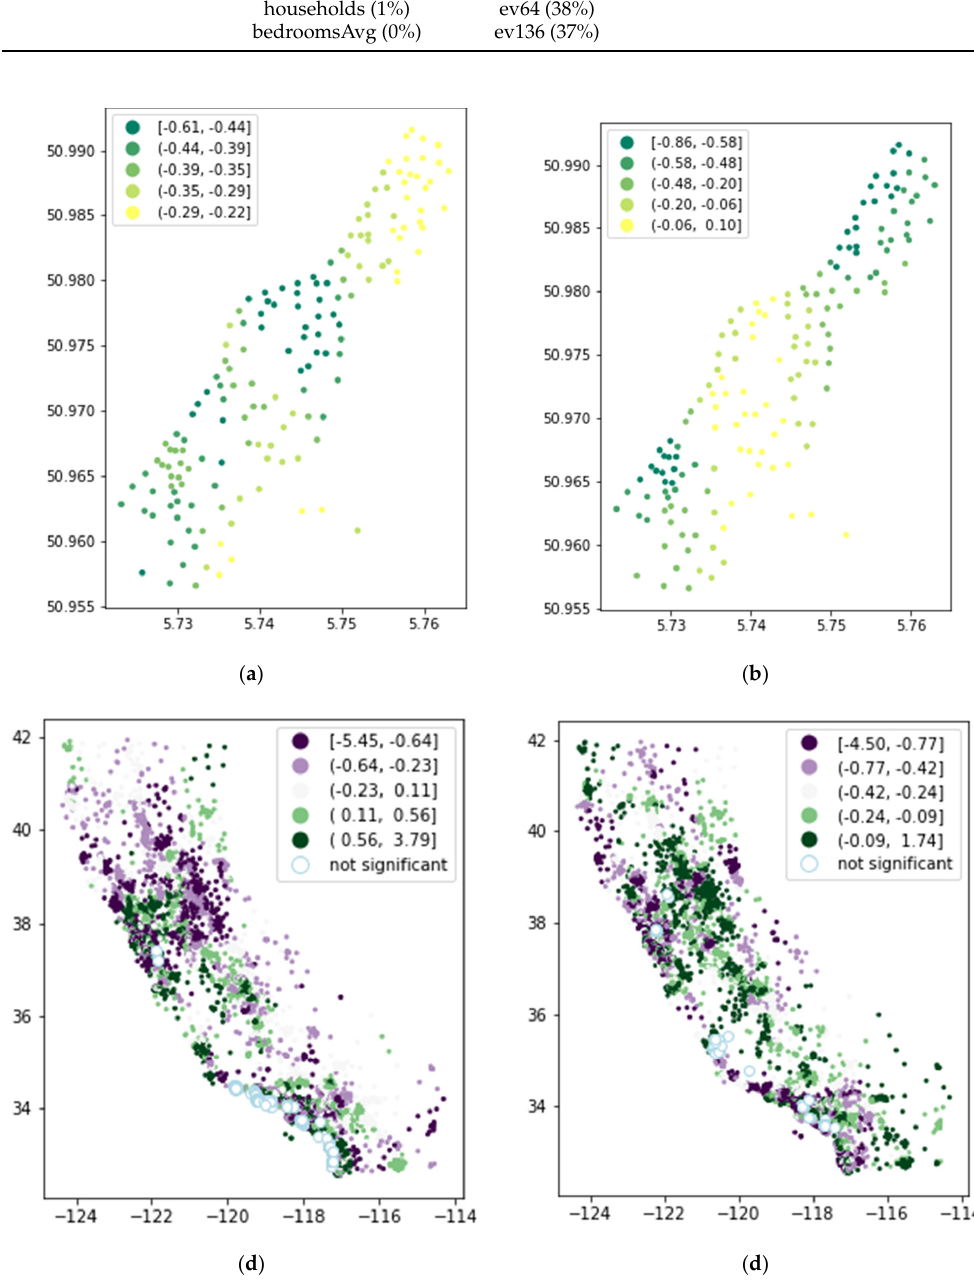
Figure 3. Distribution of standardized GWR coefficients: ( a ) Meuse dataset, elevation, ( b ) Meuse dataset, distance, ( c ) California dataset, average bedrooms, ( d ) California dataset, population. Table 4. Impact of the explanatory variables on the models. For each model, the variables are or- dered and enlisted based on their impact (e.g., the highest relative importance is at the top and the lowest at the bottom). R.I = relative importance, Coeff. = mean absolute value of the standardized estimated parameters, Insig. = number of insignificant parameters.